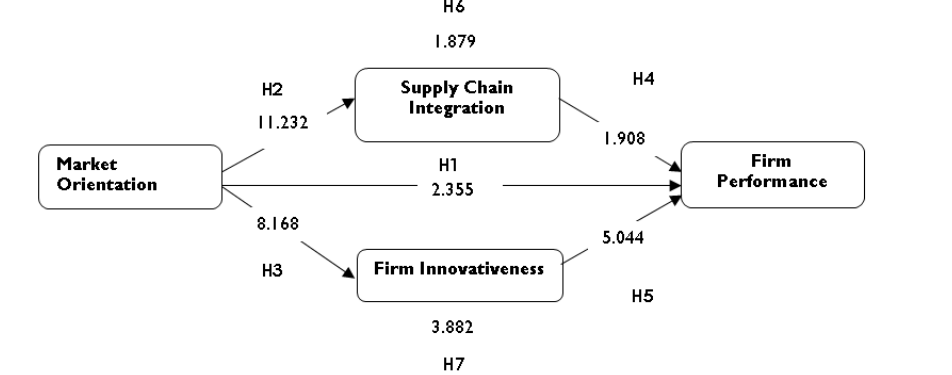
Figure 2. Hypothesis Testing Result